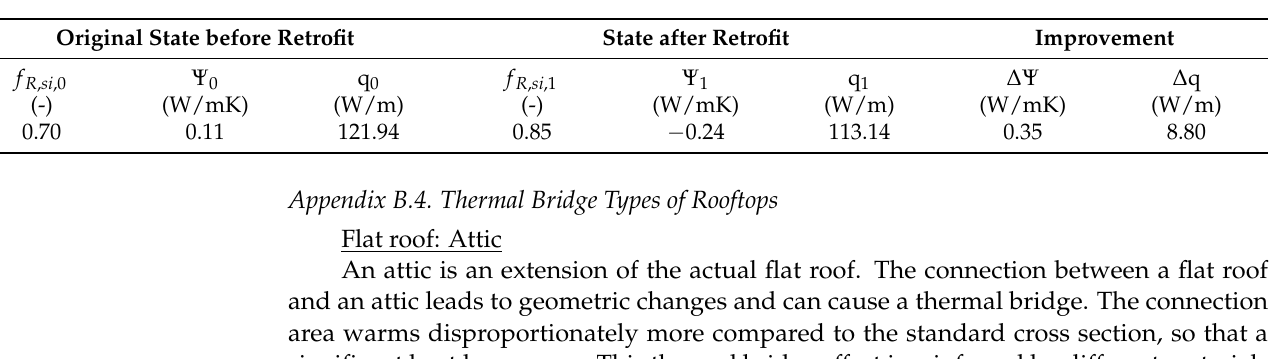
Table A21. Quantifiable results of the thermal bridge retrofit of a roller shutter casing (ThermCad thermal bridge simulation calculation).